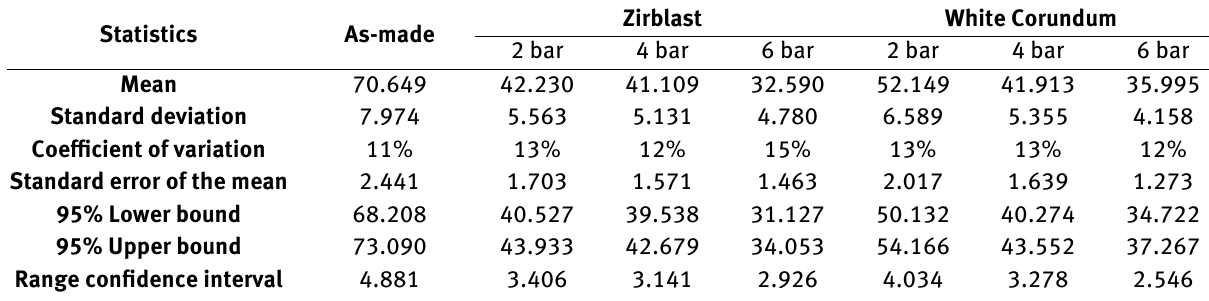
Table 6: Statistical analysis of parameter Rt.